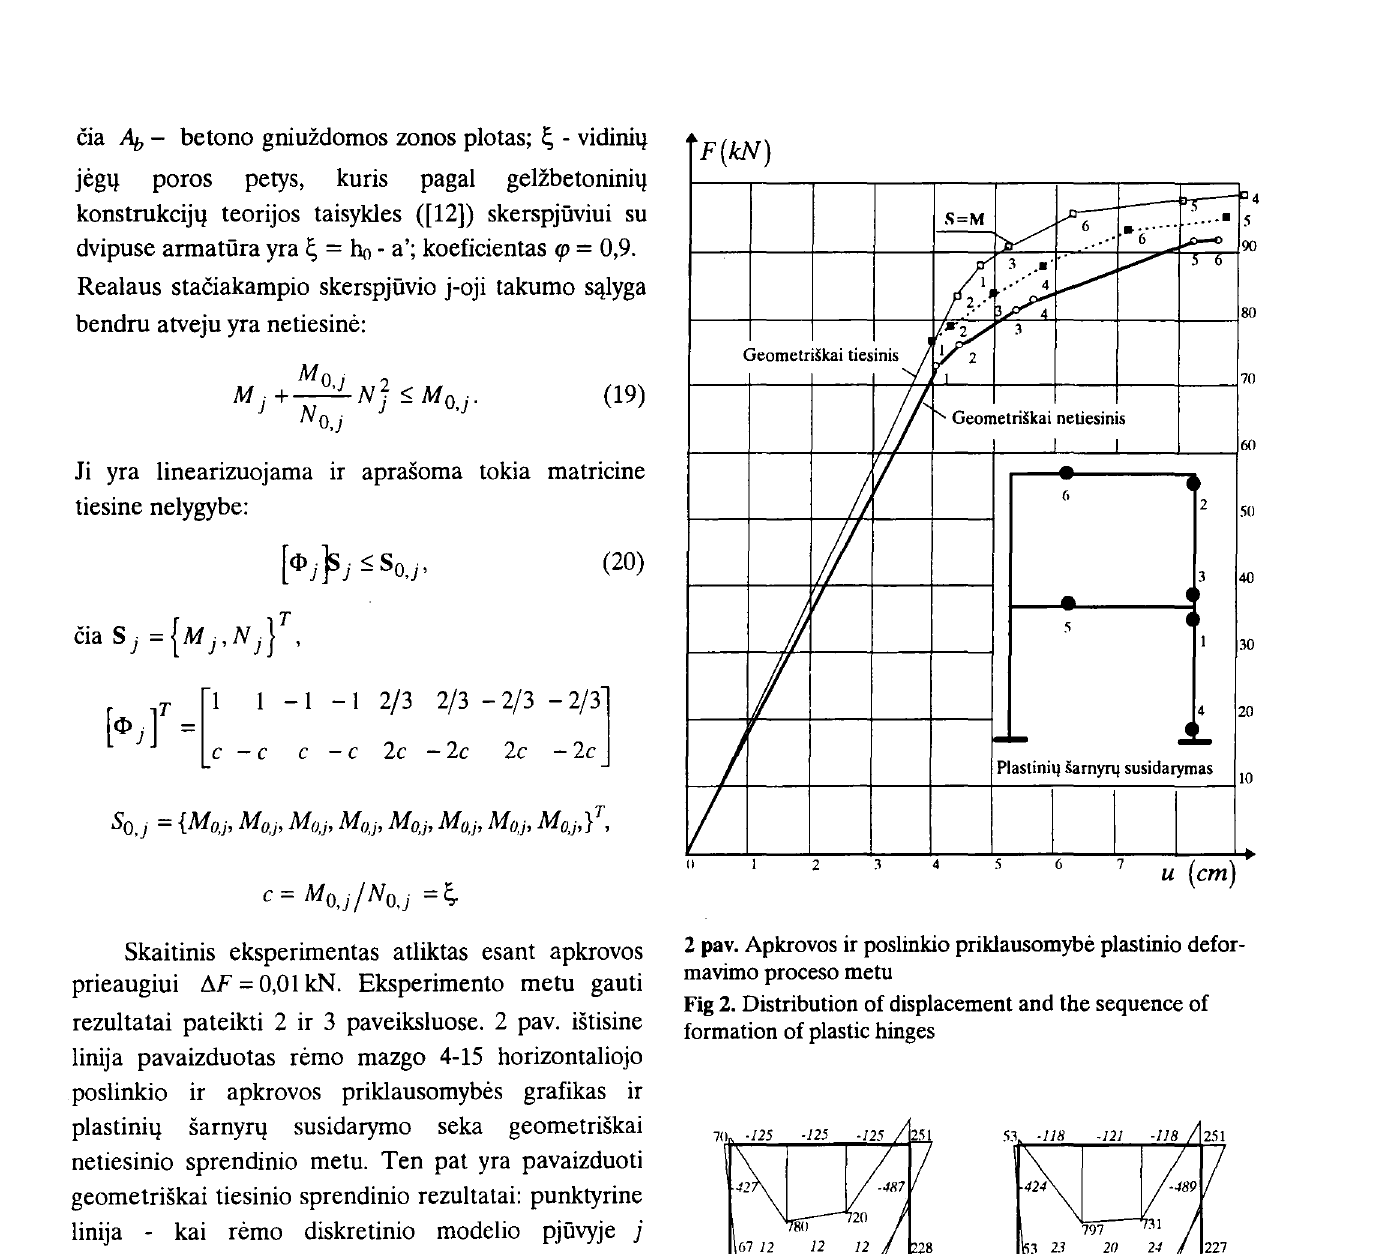
Geometriskai tiesinis Geometriskai netiesinis